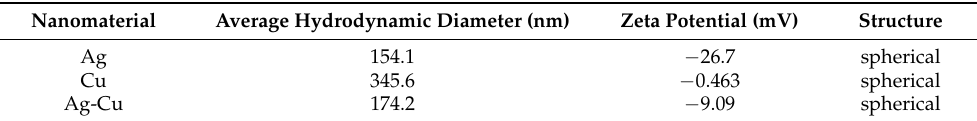
Table 1. Physicochemical parameters (average hydrodynamic diameter, zeta potential, and structure) of nanoparticles used (Ag, silver nanoparticles; Cu, copper nanoparticles; Ag-Cu, silver–copper